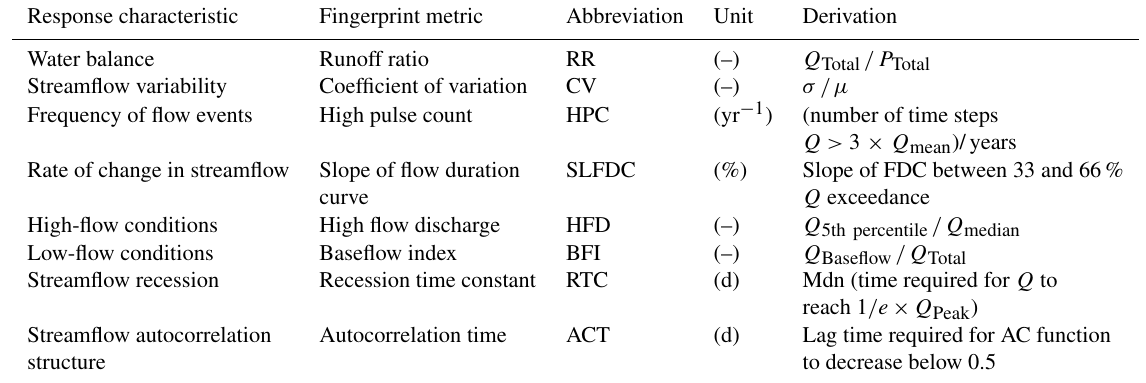
Table 1. Temporally aggregated single-value fingerprint metrics derived from FAST-mHM simulated streamflow and observed precipitation time series, serving as model response targets for sensitivity analysis